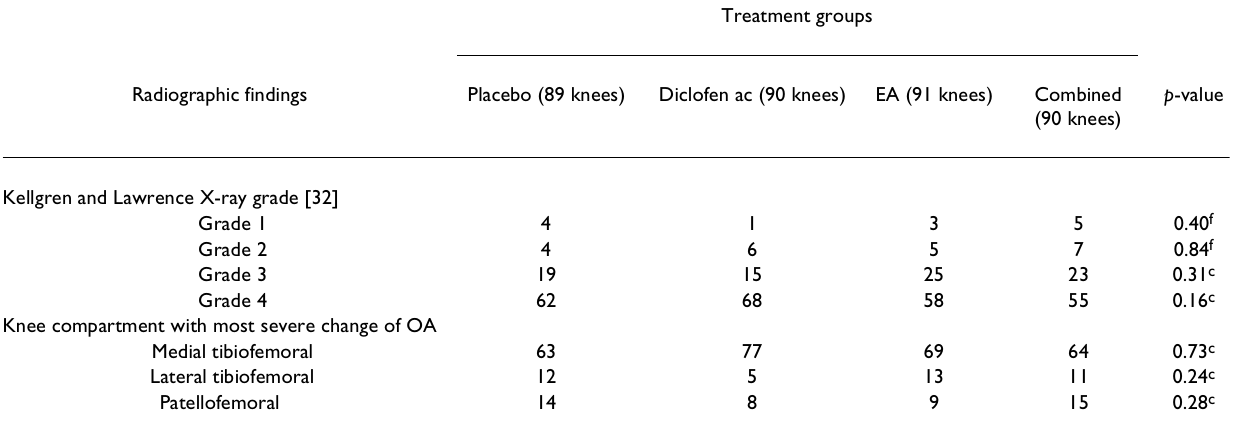
Table 3: The radiographic findings at entry into the study * .